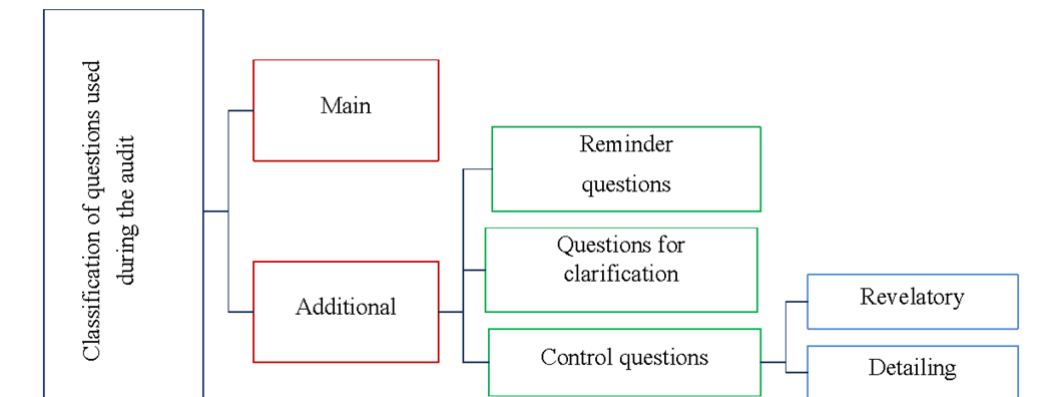
Fig. 2. Classification of questions used during the